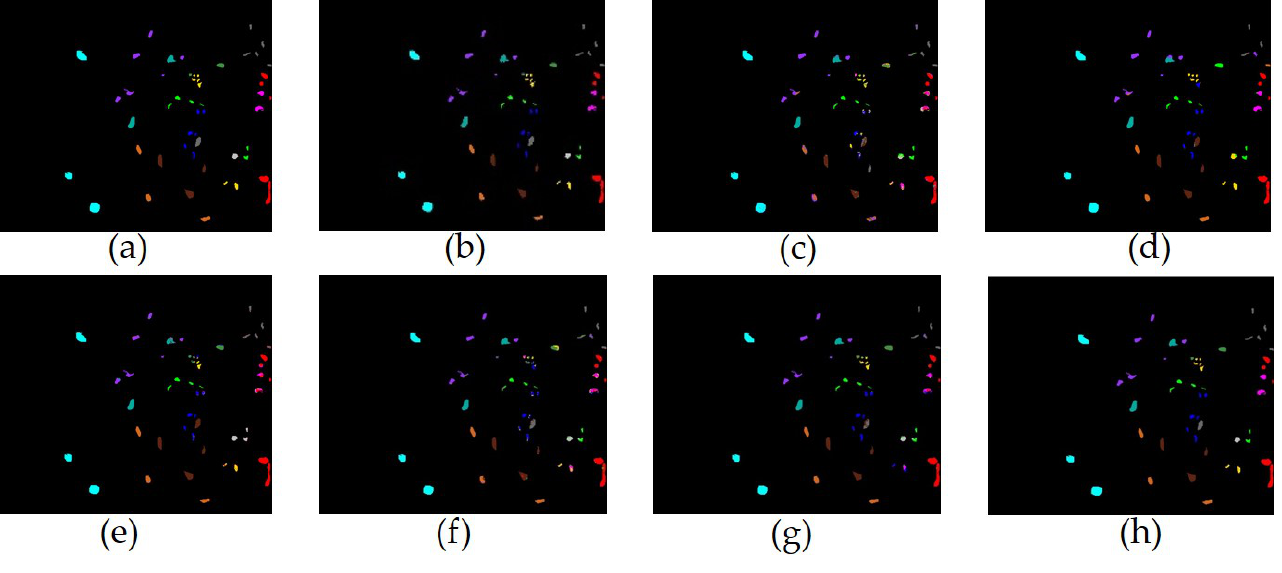
Figure 8. Classification maps for KSC dataset. ( a ) Ground-truth map; ( b ) SVM-3DG; ( c ) 1D-CNN; ( d ) 2D-CNN; ( e ) 3D-CNN; ( f ) MSDN-SA; ( g ) SSRN; ( h )